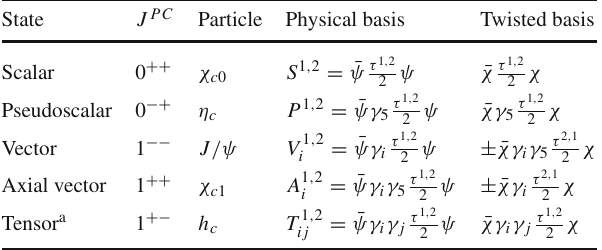
Table 2 Typical interpolators for meson states and relations between physical and twisted basis. The particle name is the closest relative in nature State J PC Particle Physical basis Twisted